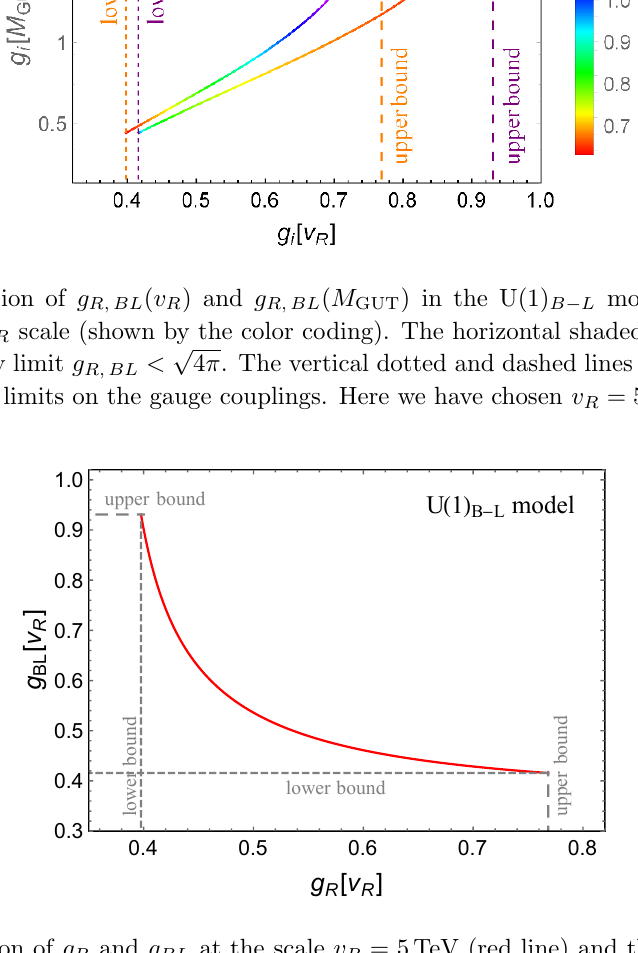
Figure 2 . Correlation of g R and g BL at the scale v R = 5 TeV (red line) and the lower and upper bounds on the couplings g R and g BL , induced from the requirement of perturbativity up to the GUT scale in the U(1) B (cid:0) L